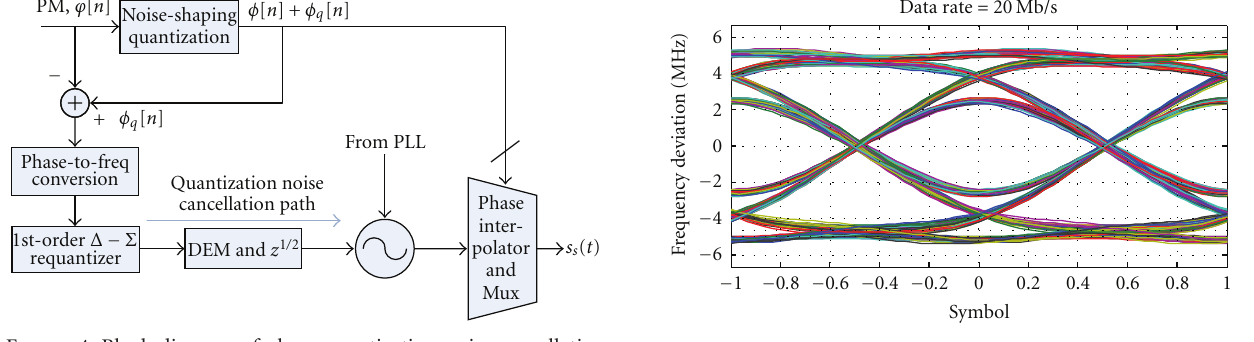
Figure 5: Eye diagram of the transmitted